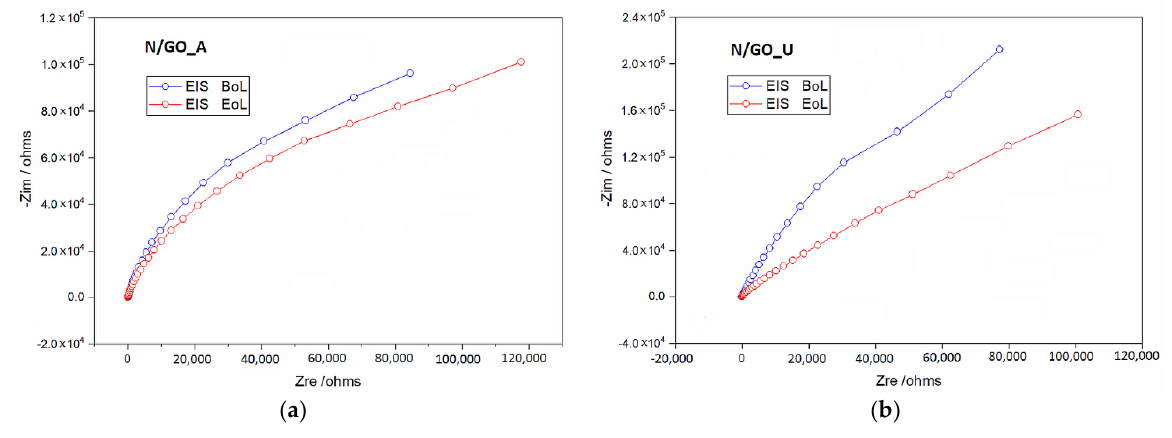
Figure 14. Nyquist plots of the catalysts N/GO_A ( a ) and N/GO_U ( b ).